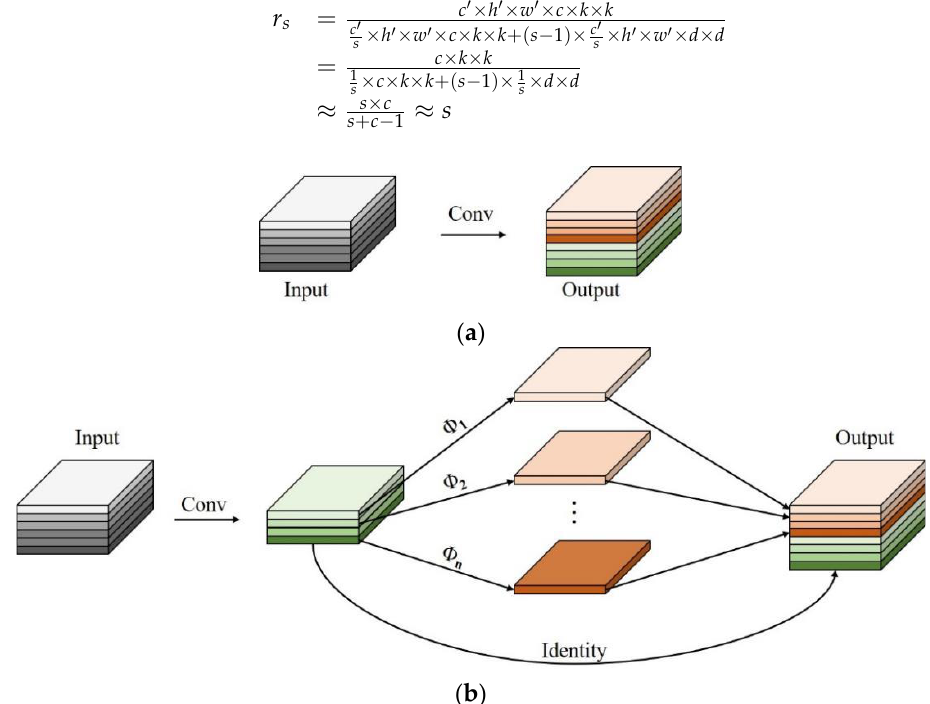
Figure 5. The working principle of traditional convolution and Ghost module. ( a ) The traditional convolution, ( b ) The Ghost module.